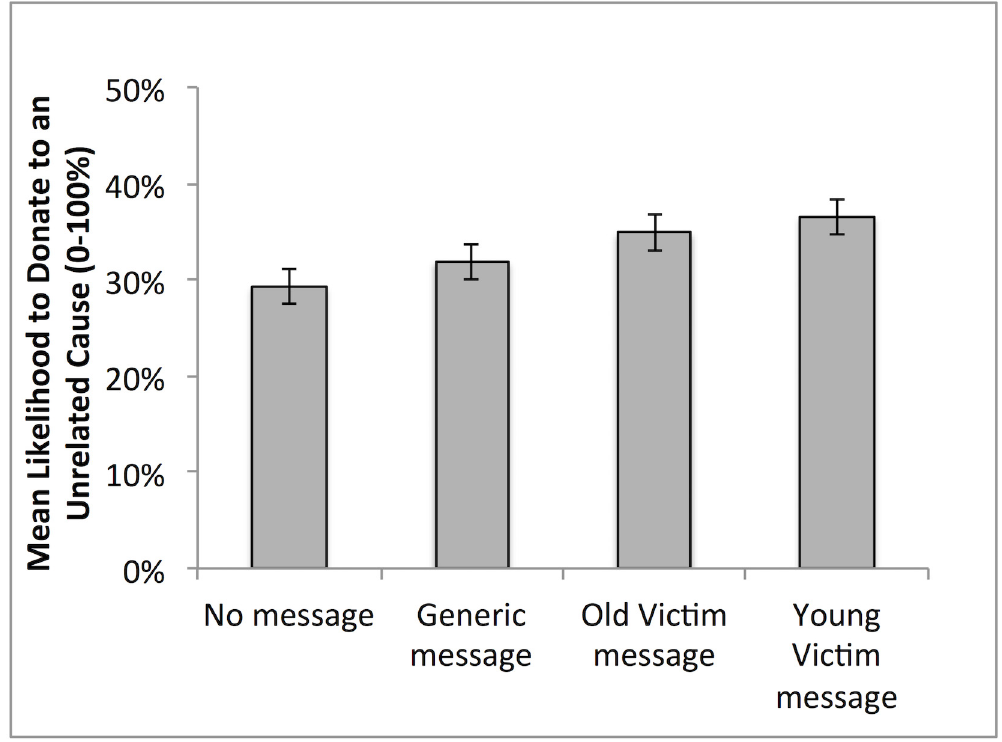
Fig 1. Mean Prosocial Motives as Measured in Rated Likelihood to Donate to an Unrelated Cause. Error Bars: ± 2SEs (95%